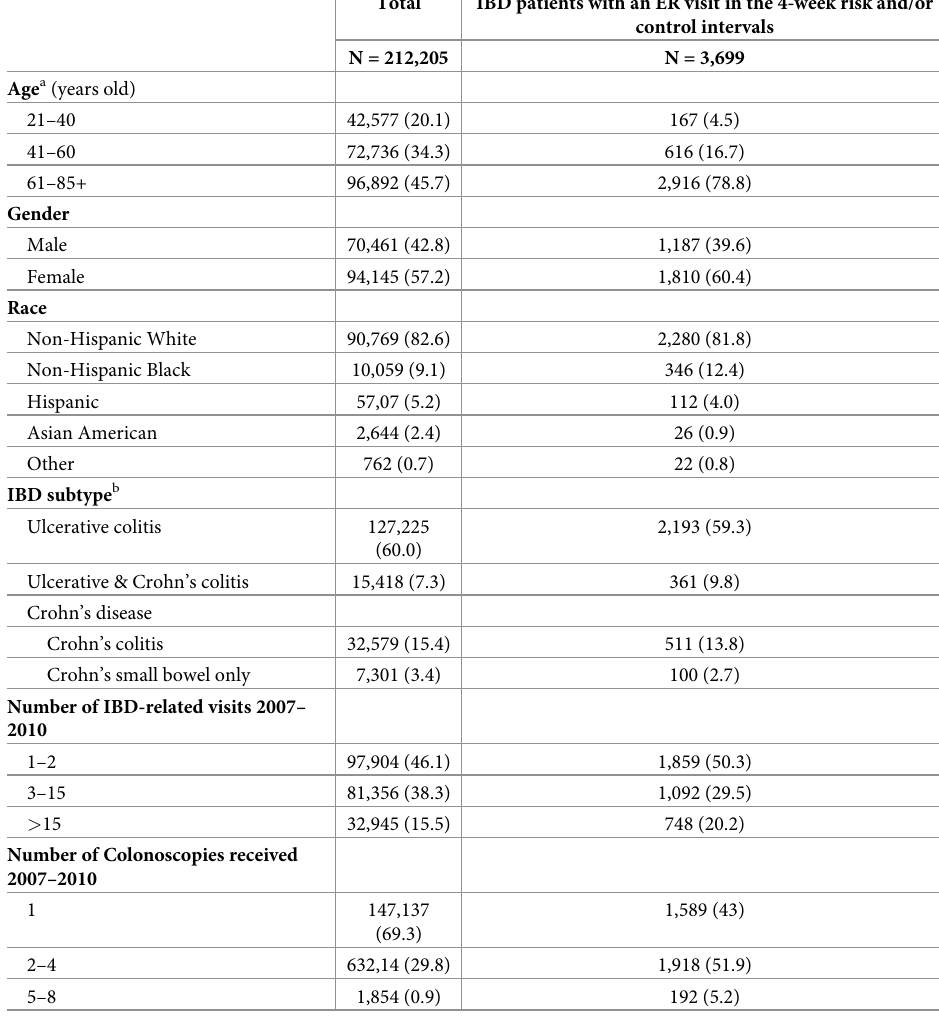
Table 1. Baseline demographics and disease characteristics, n